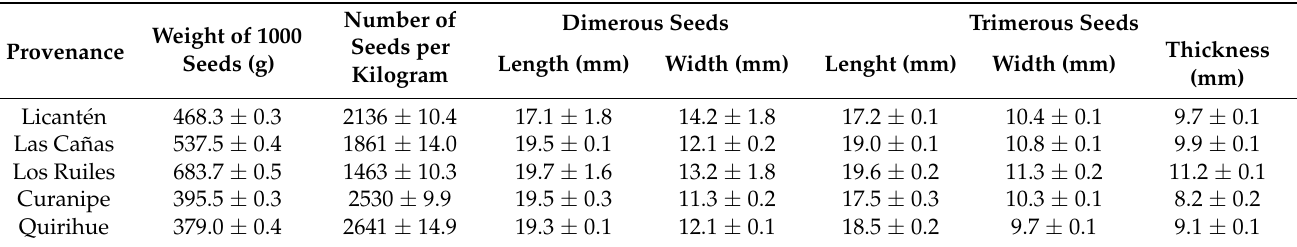
Table 3. Weight and morphometric characterization of the seeds from five provenances of Nothofagus glauca (mean ± Standard